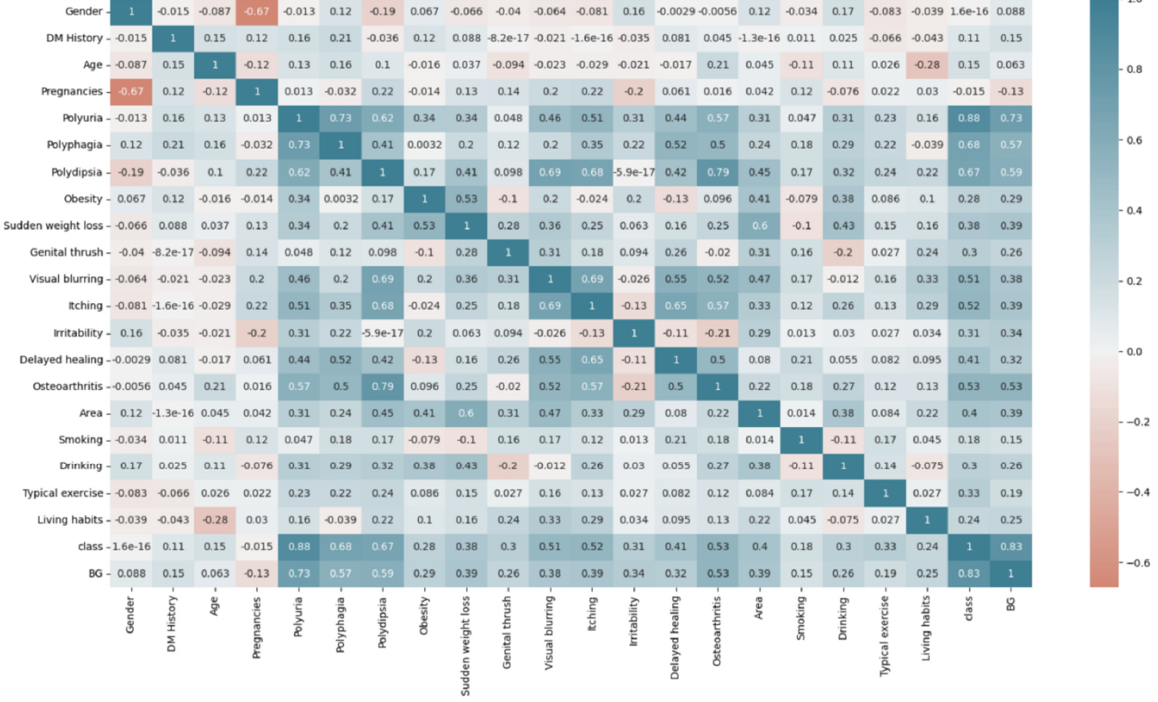
Figure 1. Questionnaire risk factor correlation.